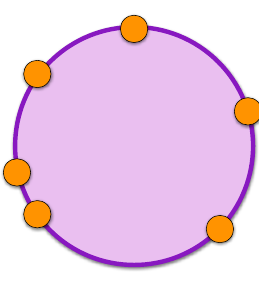
Figure 3 . Disk diagram. The orange circles on the boundary represent the insertion of meson